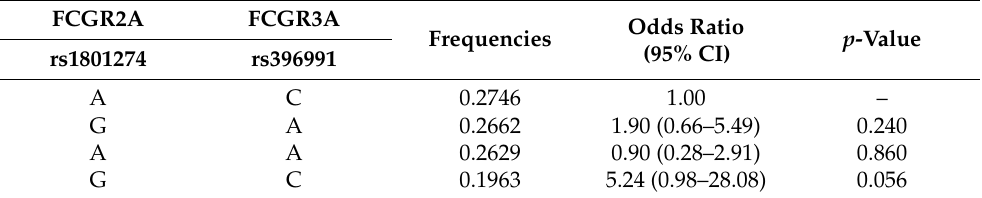
Table 4. Haplotype association with EULAR response at 6 months of ABA adjusted by sex, duration of previous BTs, monotherapy, and initial